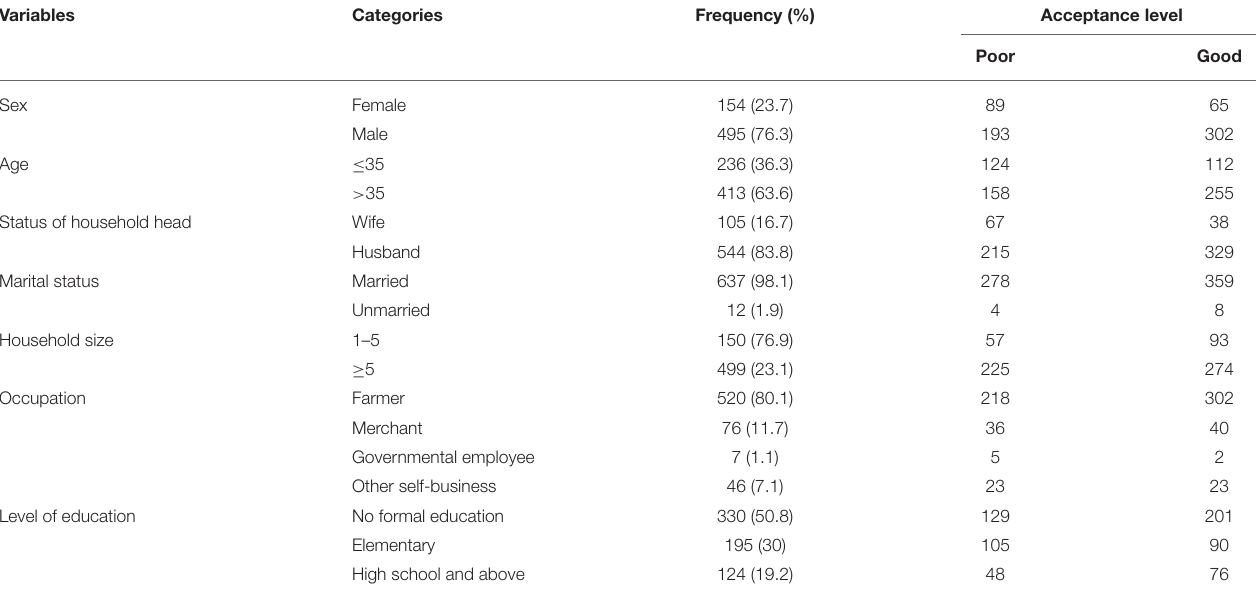
TABLE 1 | Socio-demographic characteristics of the study population ( N = 649) in Shewa Robit town, North Eastern Ethiopia, 2021. Variables